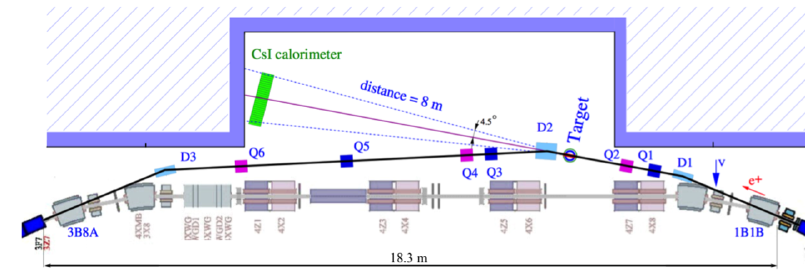
Figure 7. Proposed by-pass line at VEPP-3 in